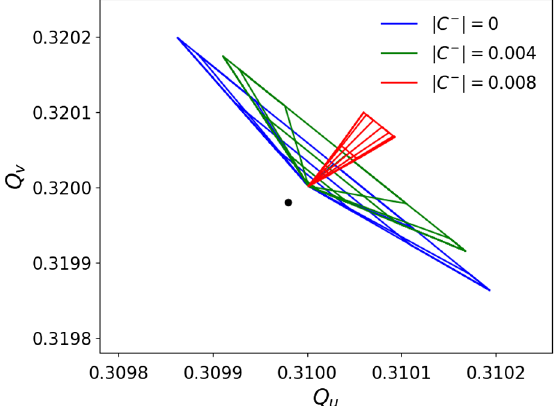
¼ 500 A. The oct